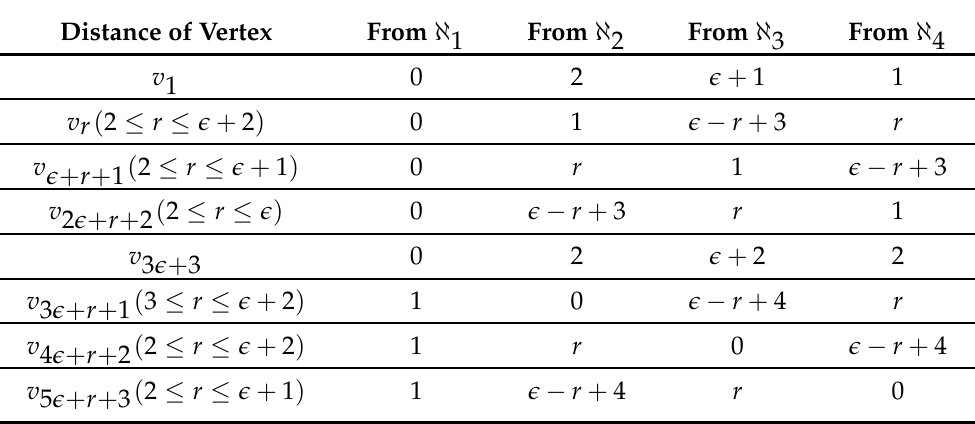
Table 10. Distance codes of V ( f α × 3 ) with respect to ℵ